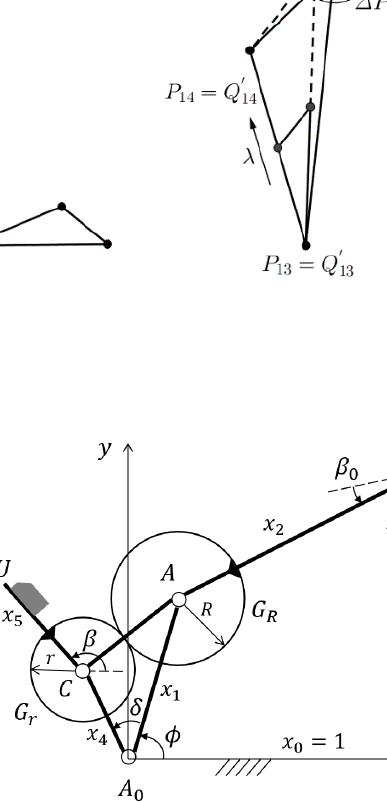
Figure 10. Compliant geared